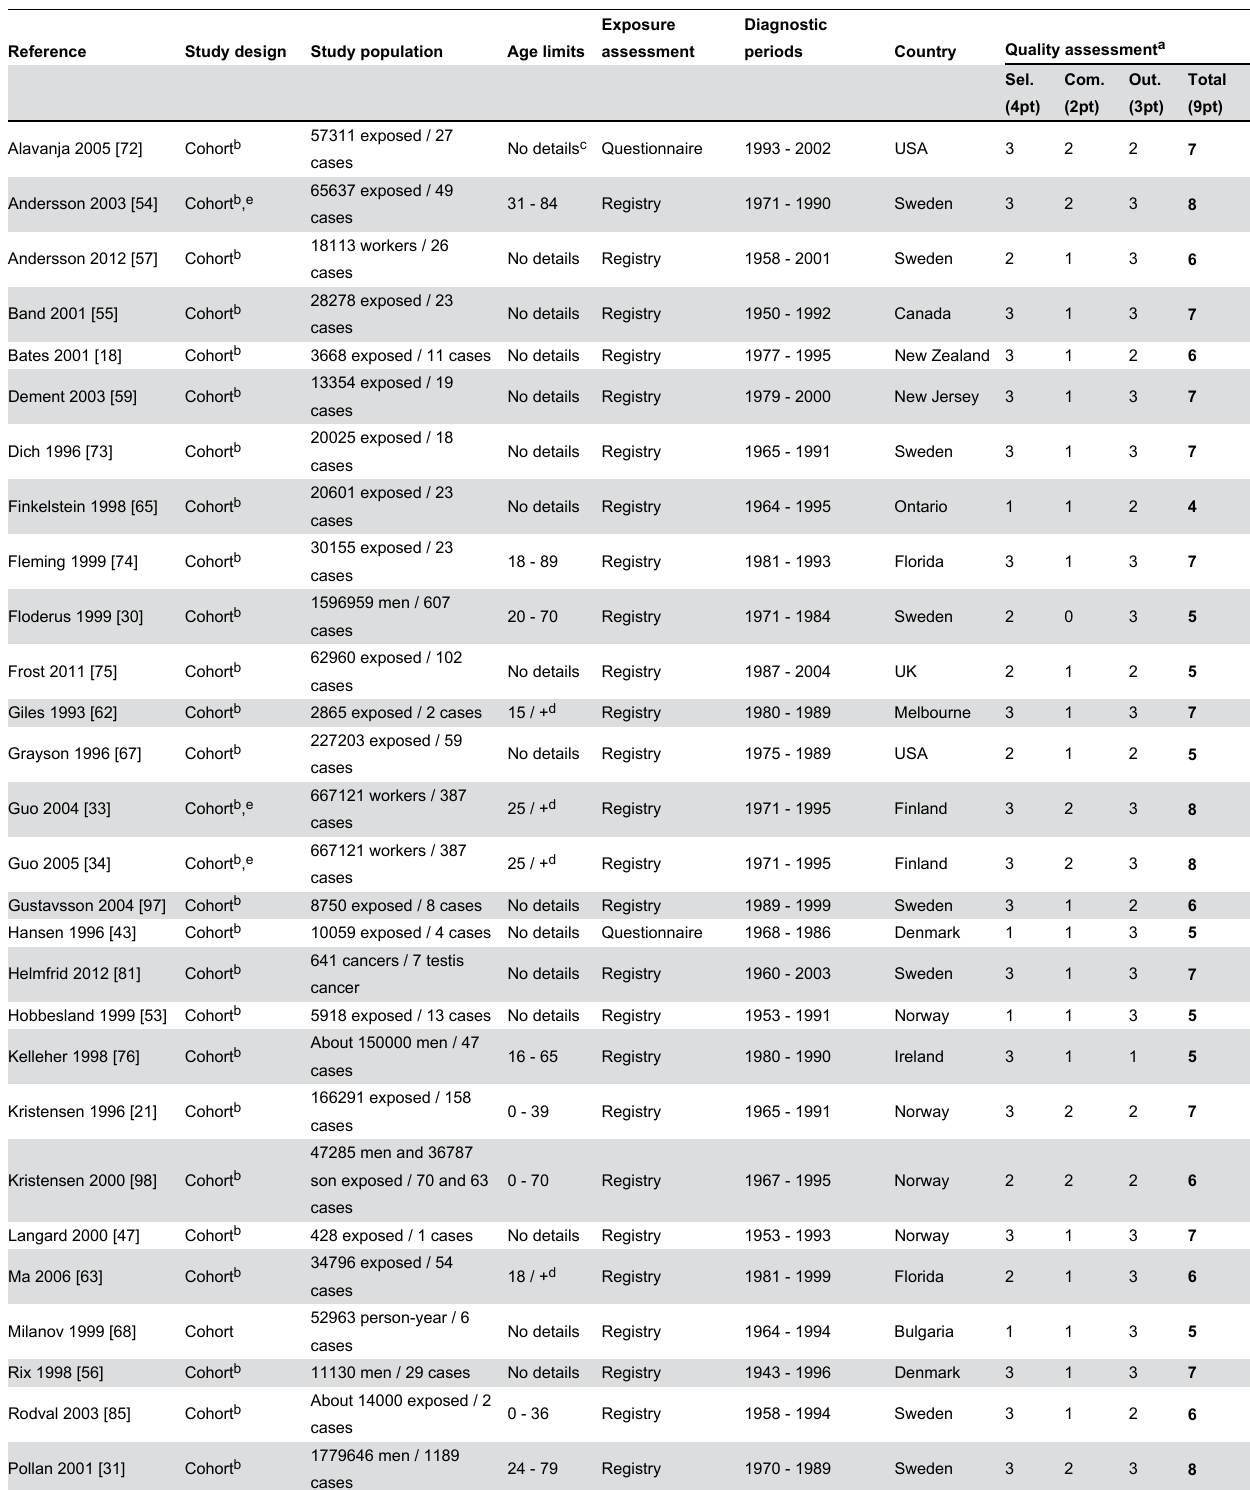
Table 1. Description of selected